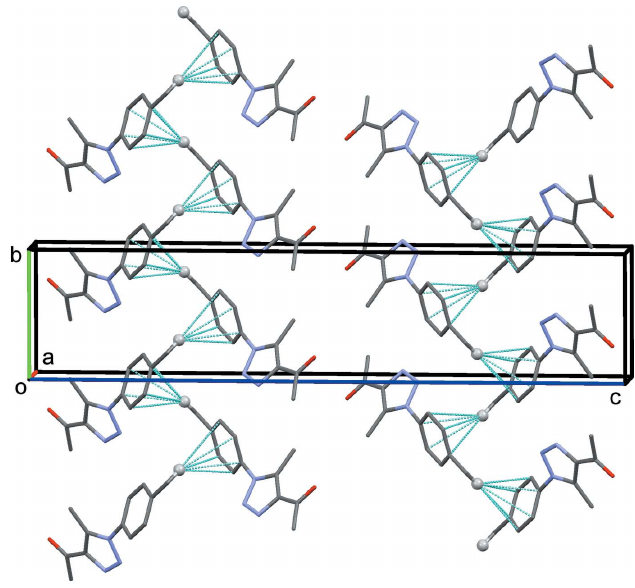
Figure 2 A view along the a axis of the crystal packing of the title compound. The C—H (cid:3)(cid:3)(cid:3) (cid:2) interactions are represented by dashed lines [see Table 1; only H atom H1 C (grey ball) has been